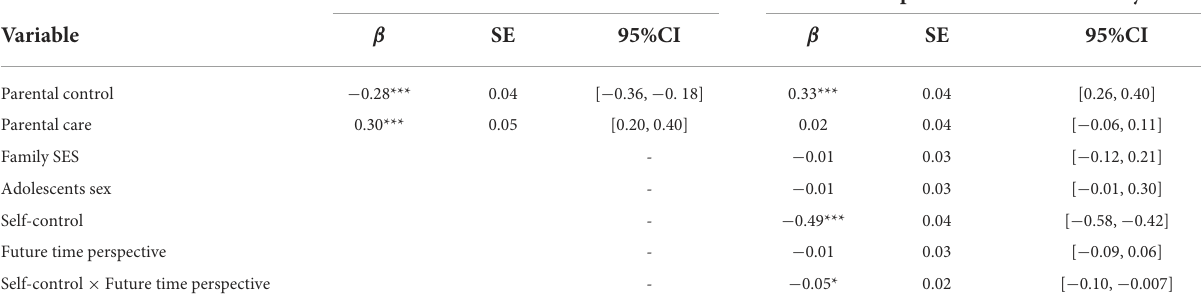
TABLE 3 Summary for the mediation